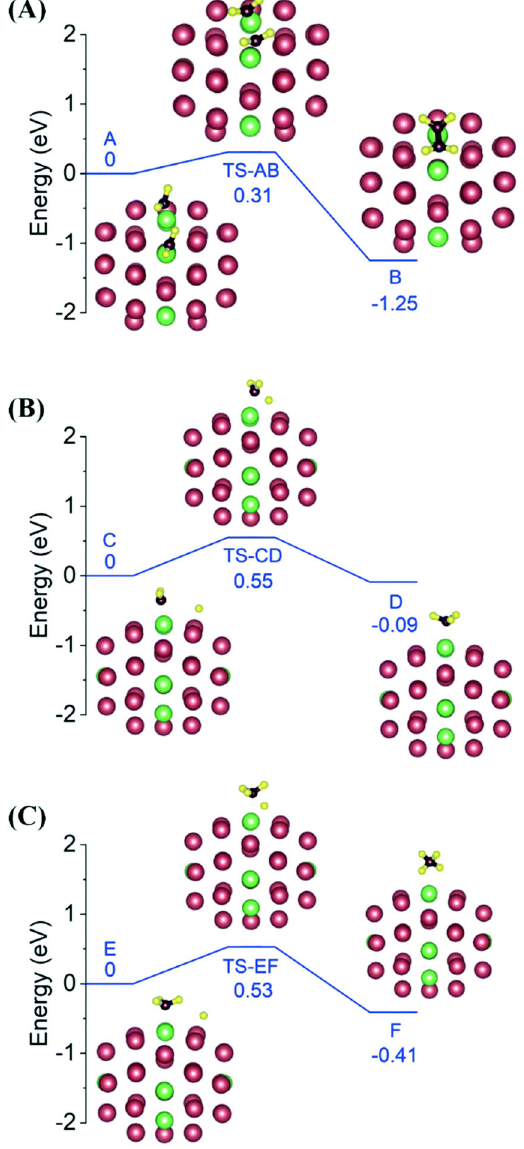
Figure 9. The optimized geometries of reactants, transition states and products for ( A ) CH 2 + CH 2 coupling, ( B ) CH 2 hydrogenation and ( C ) CH 3 hydrogenation on a Pt 42 -Ru 8 bimetallic cluster, respectively. Reproduced with permission, Copyright 2022 The Royal Society of Chemistry [55]. Table 4. The reaction energy barriers calculated via VASP software. Reproduced with permission, Copyright 2022 The Royal Society of Chemistry